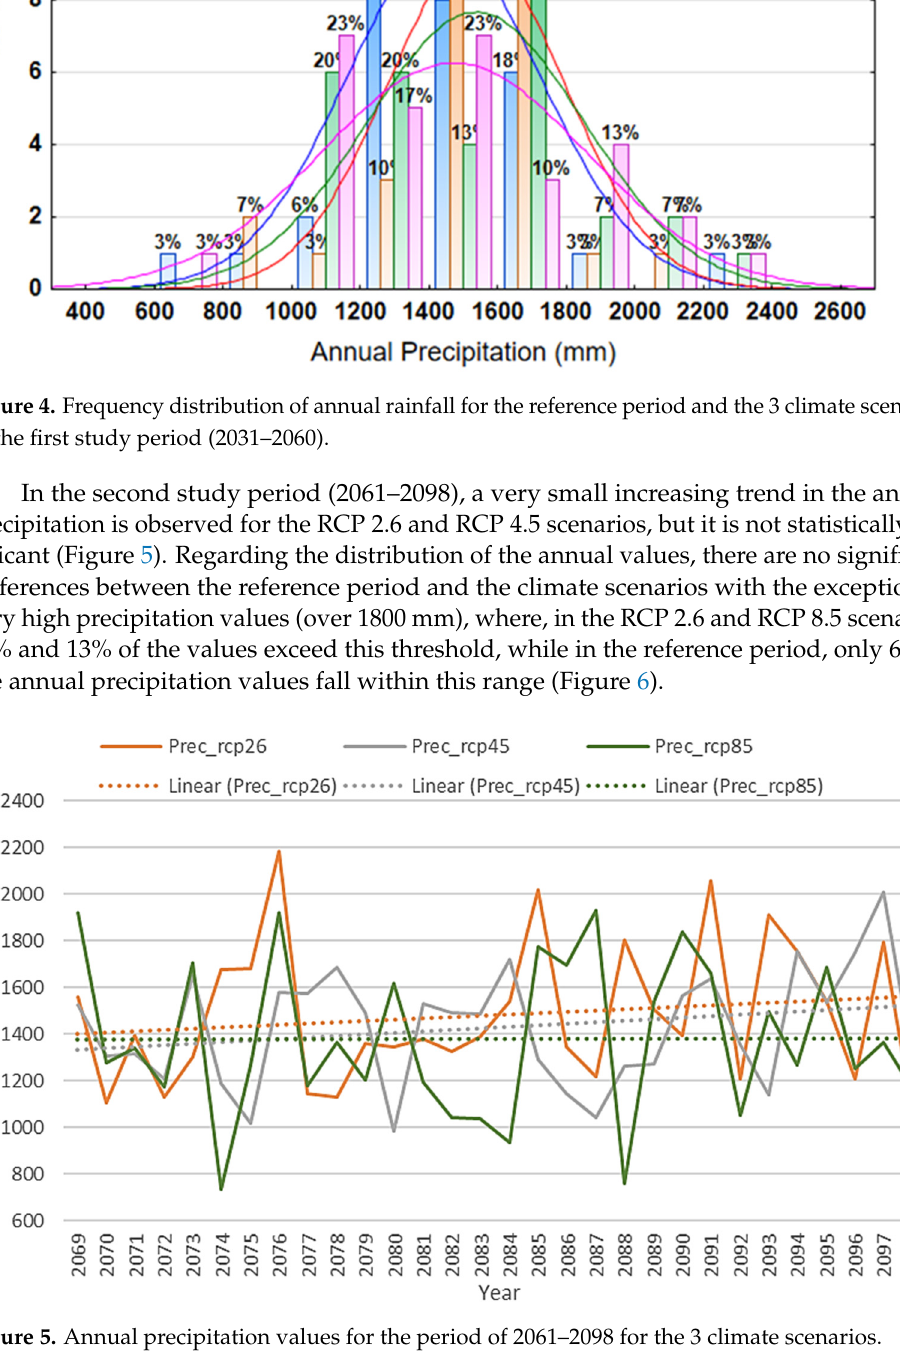
Figure 6. Frequency distribution of annual rainfall for the reference period and the 3 climate scenar- ios of the second study period (2061–2098). Regarding the average monthly rainfall values, the months of October, November, and December present the highest values during the reference period (219–247 mm), while in the remaining months, the average monthly values do not exceed 184 mm for the ref- erence period. The monthly values in the climate scenarios are also similar, with small differences compared to the reference period that are within the limits of the statistical error (Table 3). Based on the average percentage differences in the average precipitation values of the climate scenarios in relation to the reference period, there are some significant increas- ing trends in the months of August and May (between 40 and 60% in relation to the